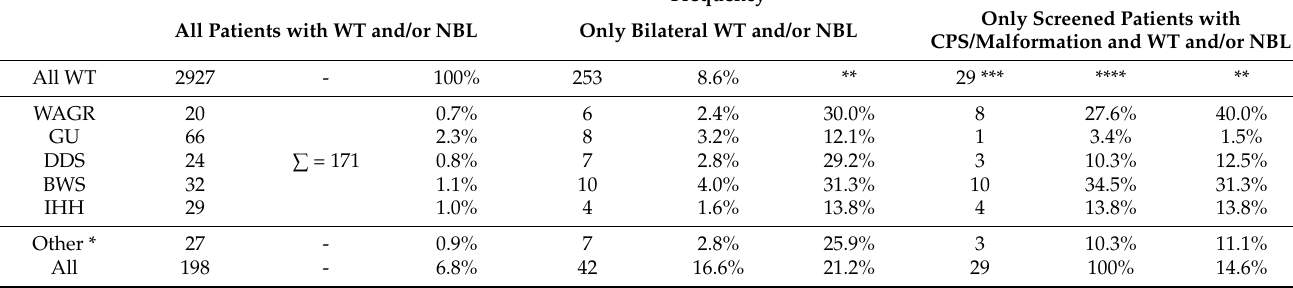
Table 1. Frequency of malformations and CPS in WT/nephroblastomatosis (NBL). Frequency Only Screened Patients with All Patients with WT and/or NBL Only Bilateral WT and/or NBL CPS/Malformation and WT and/or